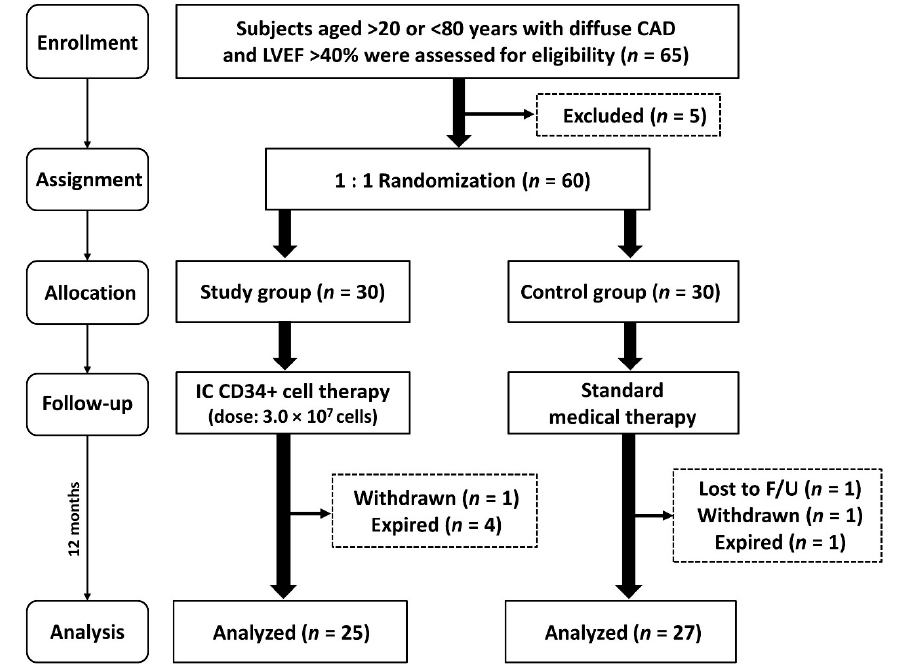
Figure 1. The flow chart showing the enrollment, assignment, allocation, follow-up and analysis in this phase II clinical trial. CAD = coronary artery disease; IC = intracoronary artery; LVEF = left ventricular ejection fraction; F/U = follow.